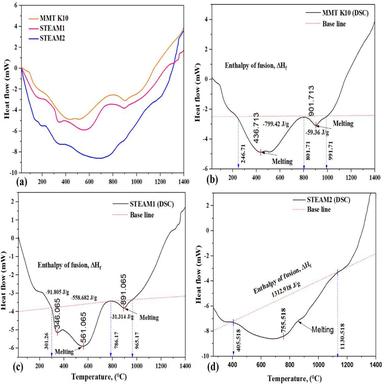
DSC relationships with temperature: (a) combined curves of MMT K10, STEAM1, and STEAM2; (b) MMT K10 curve; (c) STEAM1 curve; (d) STEAM2 curve.